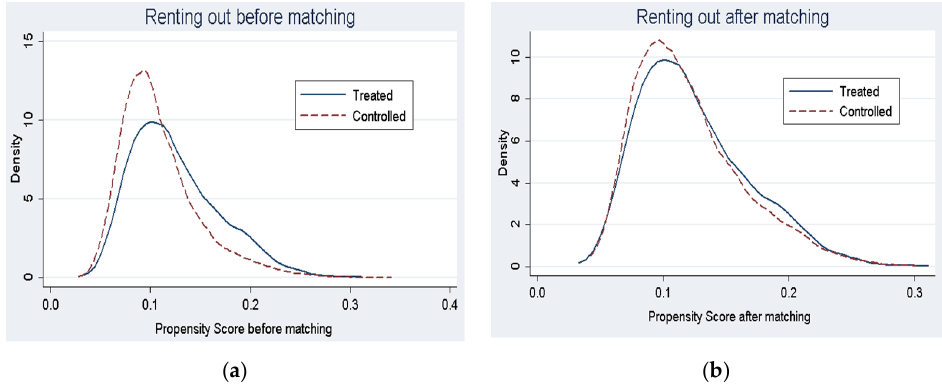
Figure 2. Common support assumption test for renting-out land density distribution of p -scores before and after matching. ( a ) Renting out before matching; ( b ) Renting out after matching.